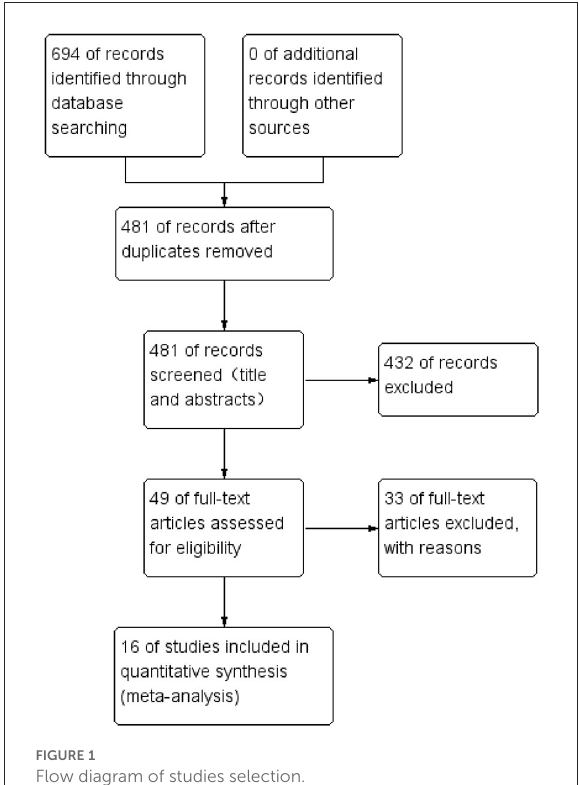
FIGURE1 Flow diagram of studies